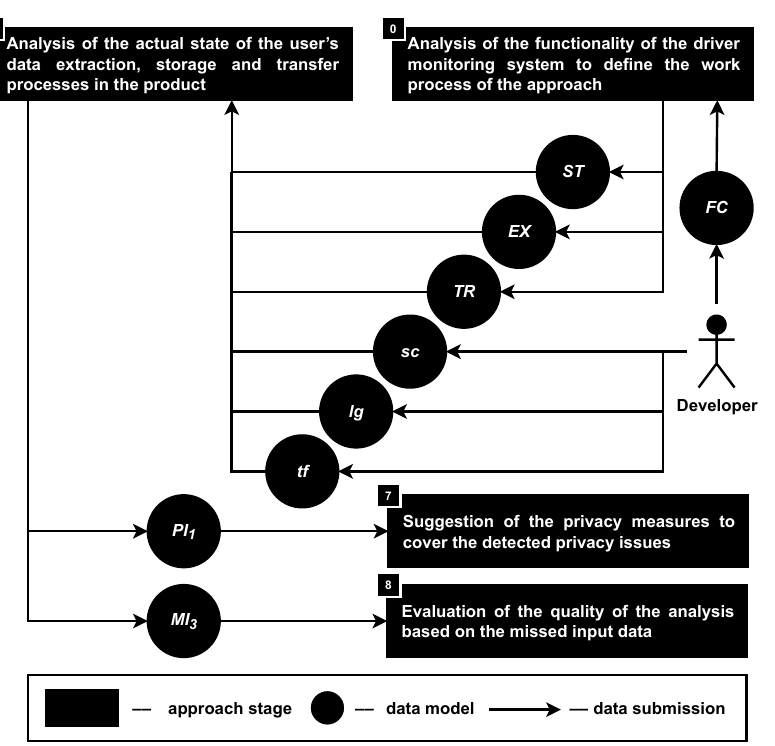
Figure 6. Stage 3—Analysis of the actual state of work with the user’s